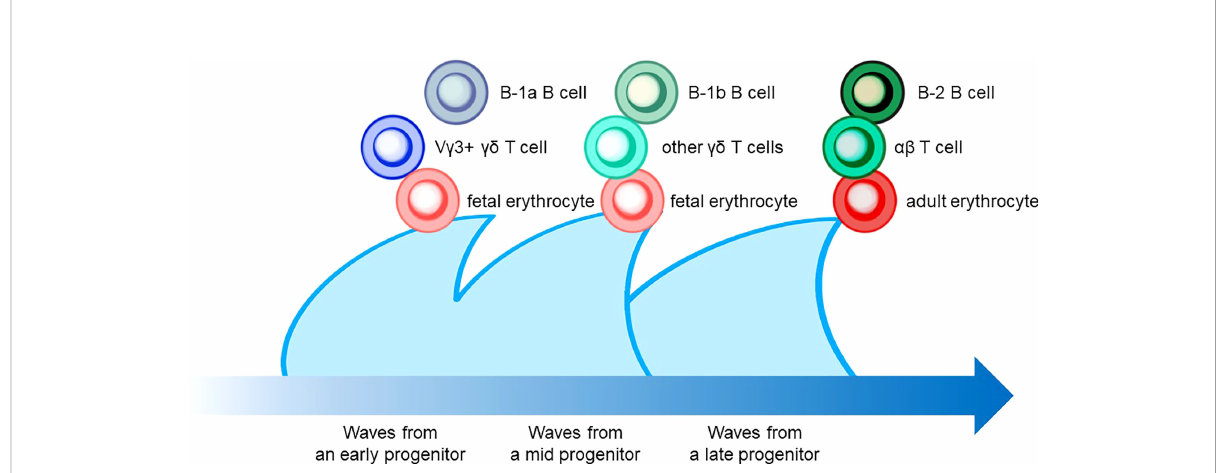
FIGURE 4 The layered immunity model which was proposed by Herzenberg et al. in 1992. A blue arrow at the bottom indicates the developmental chronology. In the concept, a hematopoietic progenitor during embryonic development generates the expansion of a unique cluster of blood and immune cells, which is described as a wave. Multiple waves generated by various progenitors compose multilayers of immune cell subsets, which collaboratively orchestrate the “ organized ” immunological function. Examples include B-cell, T-cell, and erythrocyte lineages that are derived from hematopoietic progenitors in different